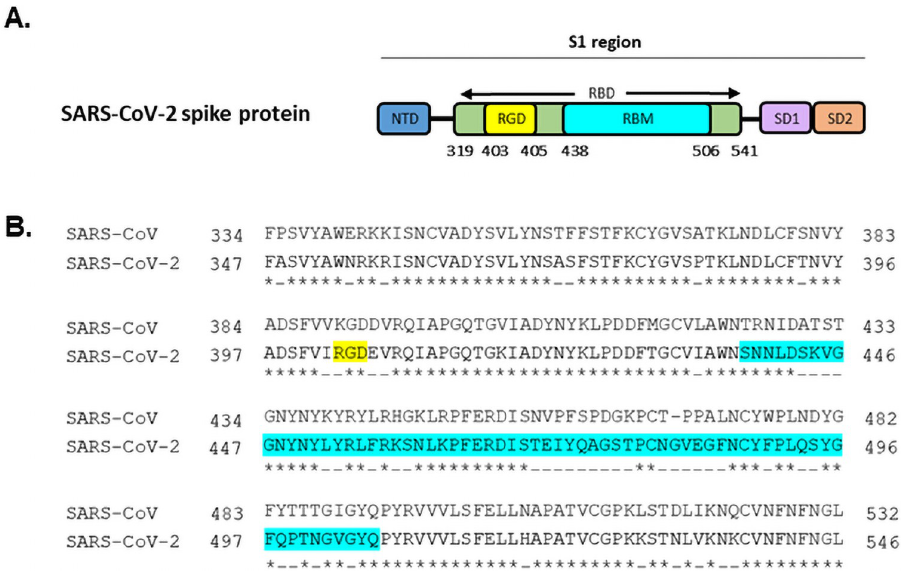
Fig 2. Sequence comparison between SARS-CoV and SARS-CoV-2 highlights the novel K403R mutagenesis. (A) Overall schematic drawing of the SARS-CoV-2 spike protein shows the N-terminal domain (NTD), RGD motif (Arg- Gly-Asp), receptor binding domain (RBD), receptor binding motif (RBM), sub-domain 1 (SD1), sub-domain 2 (SD2). The RGD motif resides within the receptor binding domain but adjacent to the ACE2-binding region (RBM). (B) Pairwise sequence alignment using EMBL-EMBOSS Needle contrasts the spike protein of SARS-CoV and SARS-CoV- 2. Identical amino acids are signified by ( � ), dissimilar amino acids are signified by (-), RGD motif (yellow), RBM region